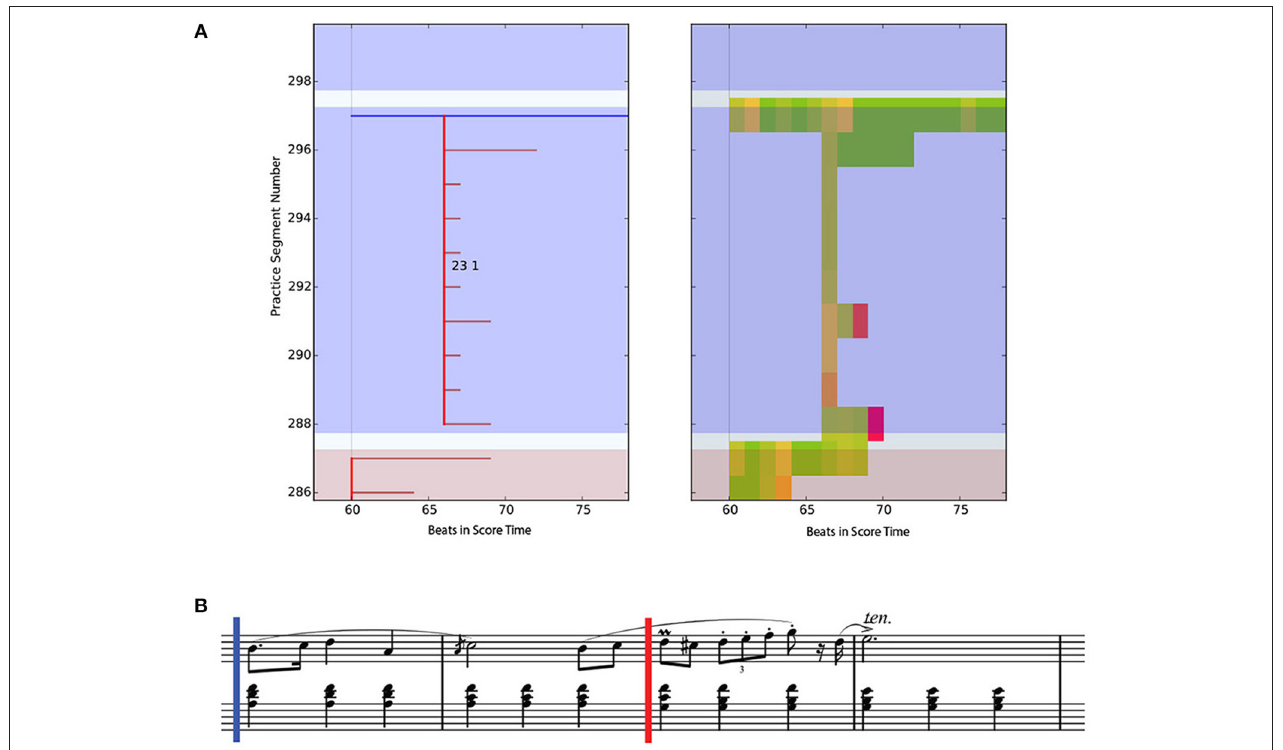
FIGURE 12 | Practice Session Work Map (top left) and Practice Session Precision Map (top right) of a Drill-Smooth practice pattern of an intermediate participant (I-1) together with the score; corresponding music segment is shown in the score (lower part of figure). (A) Left - Practice Session Work Map with color annotations of drills (dark red) and smooth (blue). Right - Practice Session Preci- sion Map with color annotations of correct (green) and incorrect (red) percentage of notes in a beat. (B) Corresponding score. The point of interest starts at the red vertical line (m. 23 beat 1).